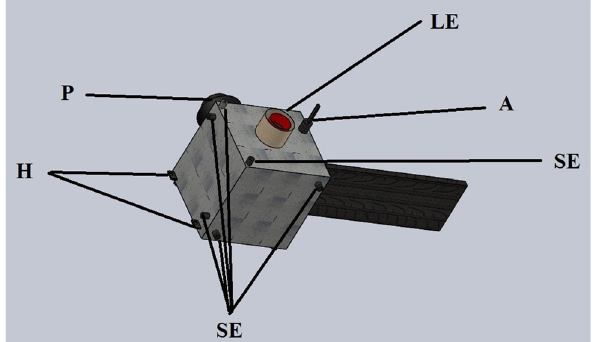
Figure 4: Rear view 1 of the micro/nanosatellite. LE: large - thrust engine; A: communication antenna; SE: small - thrust engine; P: remote sensing payload; H: hook system for the removal net and